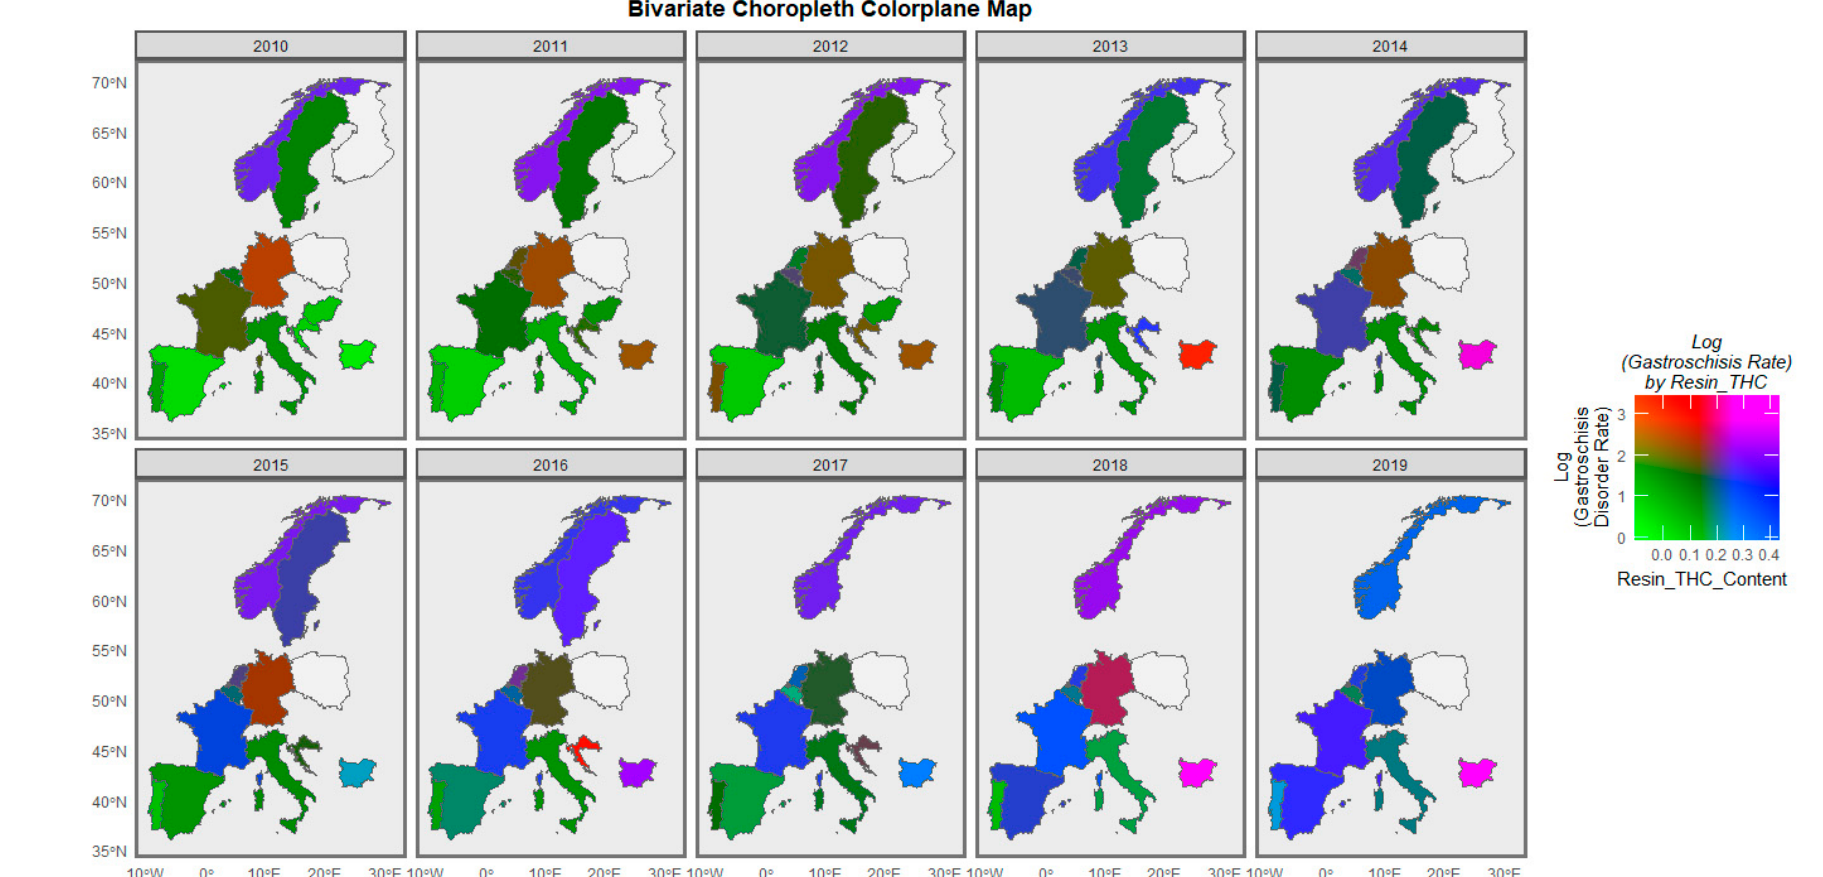
Figure 9. Bivariate colorplaner sequential map-graph of gastroschisis by cannabis resin THC concentration across selected European nations for each year of 2010–2019.